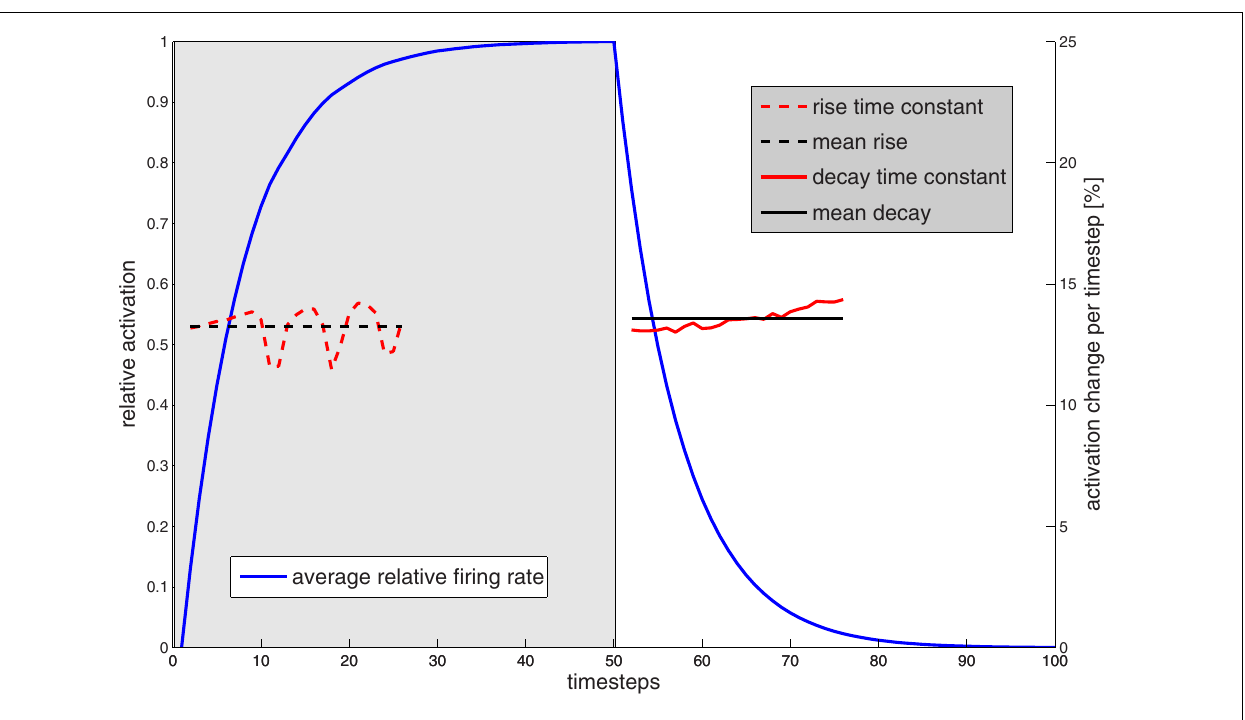
rates, which corresponds to the time constant in an exponential fixed-point dynamics, is shown in red. Black lines show the means of the respective red lines.The deviation of the blue curve from a purely exponential dynamics is apparent, but quite small, justifying the simplified dynamics as described in the